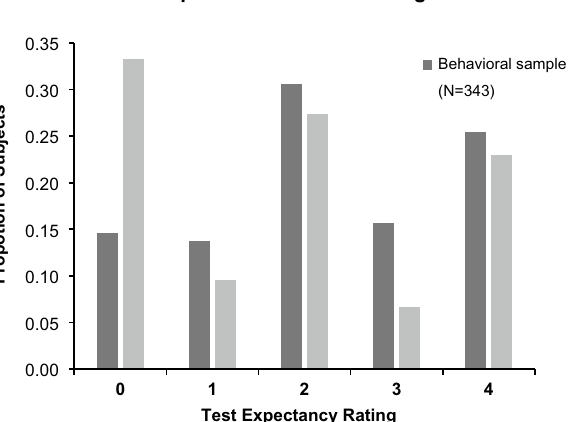
Figure 2. Proportion of participants reporting each level of test expectancy in each of the samples. (0 = not at all; 4 = certain).